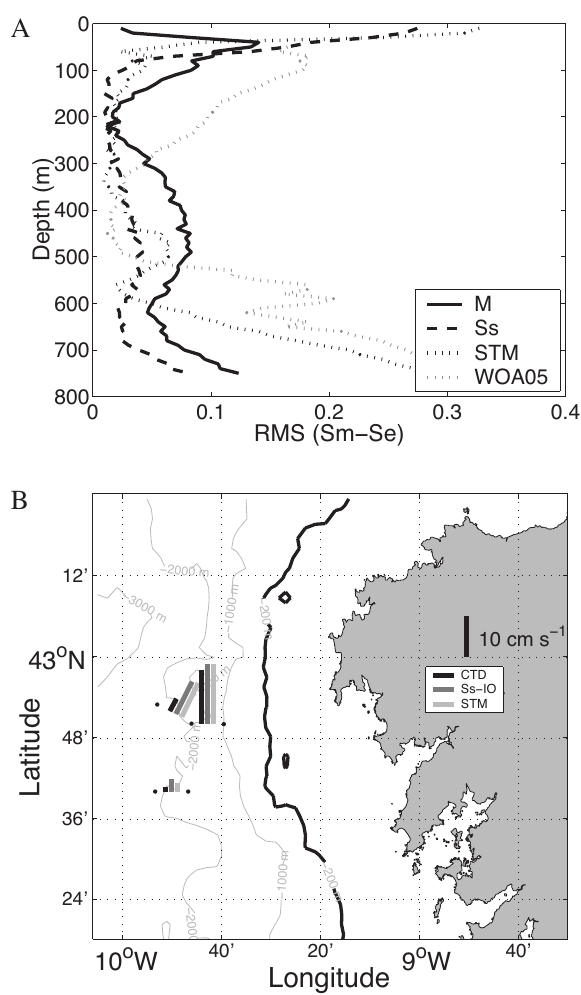
Fig . 14. – A, rms of the difference between measured and estimated salinity (see text for details); B, surface geostrophic velocity during the FINISTERRE-2006 exercise estimated with CTD data and with our best polynomial coefficients ( Ss − IO